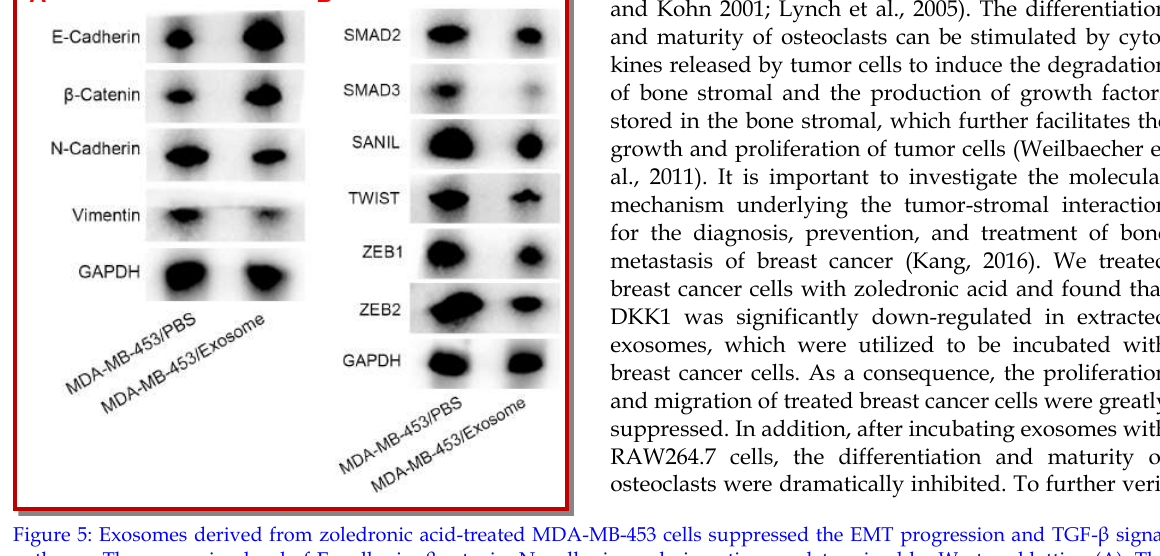
Figure 4: The effects of exosomes treated RAW 264.7 cells on the proliferation and migration of breast cancer cells. Cell viability was detected by MTT assay (A). The number of colonies was detected by the colon formation assay (B). The number of migrated cells was detected by transwell assay (C). The wound width was detected by wound healing assay (D) [p<0.05, p<0.01]